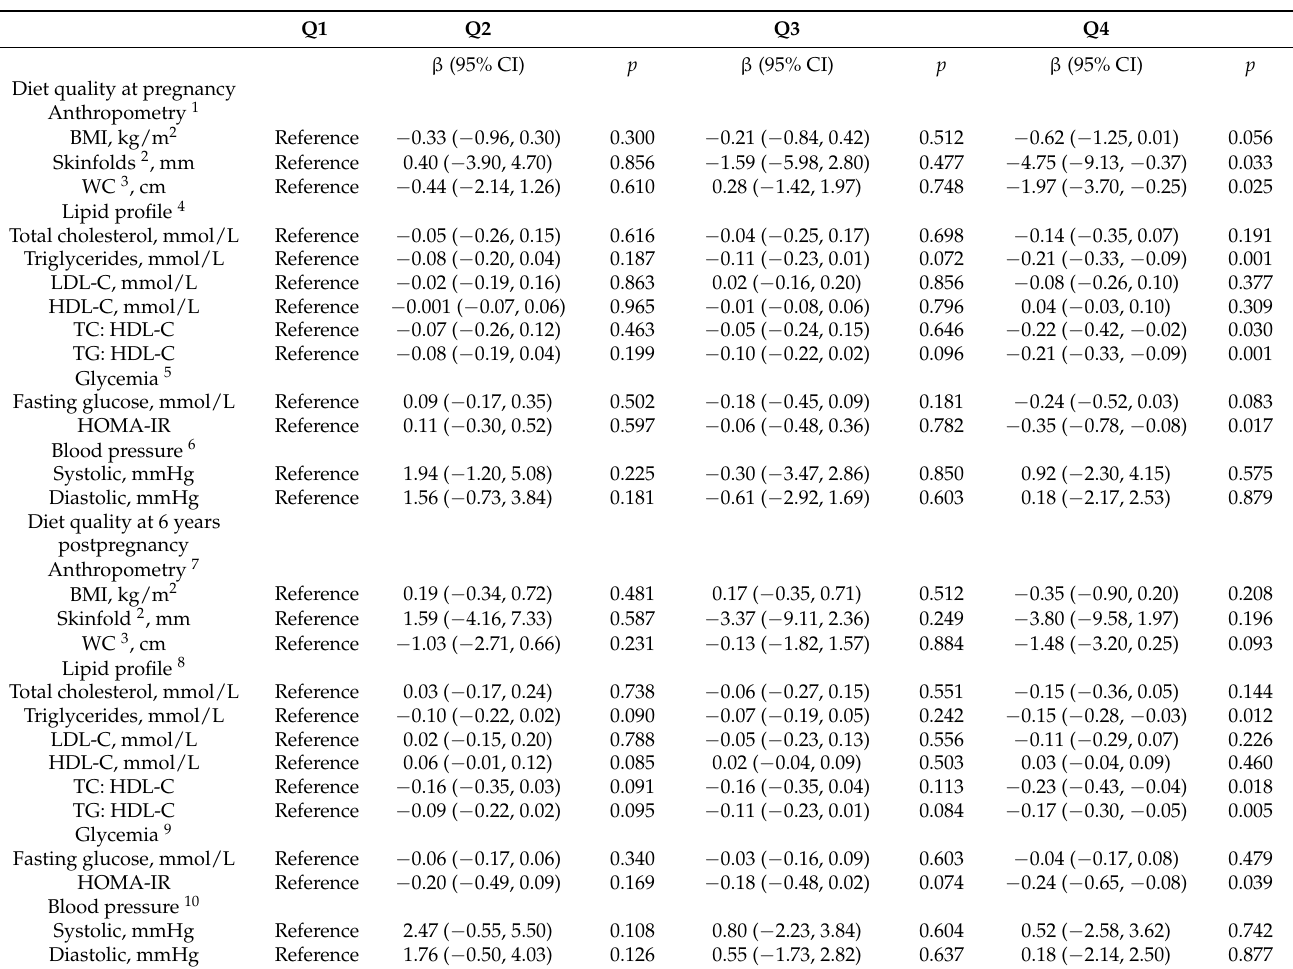
Table 3. Associations between diet quality at pregnancy or at 6 years postpregnancy and anthropom- etry and cardiometabolic markers at 6–8 years postpregnancy in women of the GUSTO